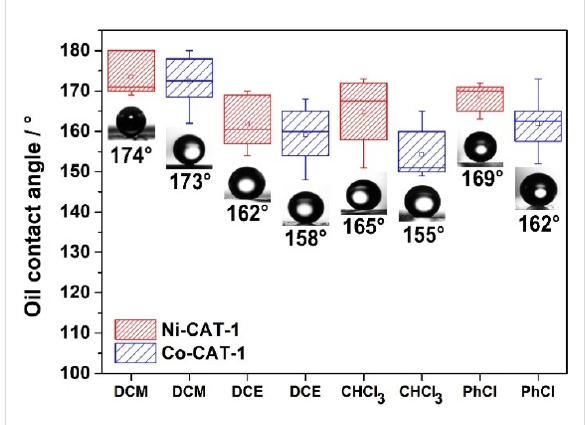
Figure 4: Box and whisker plot of the measured underwater OCAs for the nanostructured Ni-CAT-1 and Co-CAT-1 films. The employed liquids are dichloromethane (DCM), dichloroethane (DCE), chloroform (CHCl 3 ) and chlorobenzene (PhCl). For all the tested liquids,a super- oleophobicity is observed with underwater OCAs >